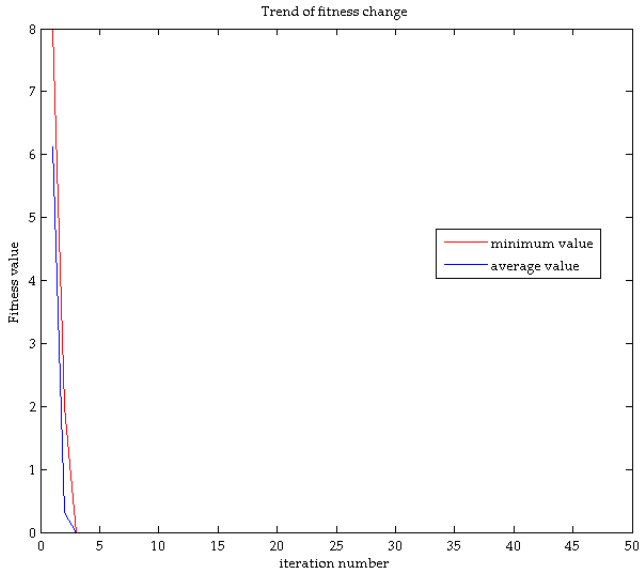
Figure 5. The trend of adaptation value of the shortest distance.